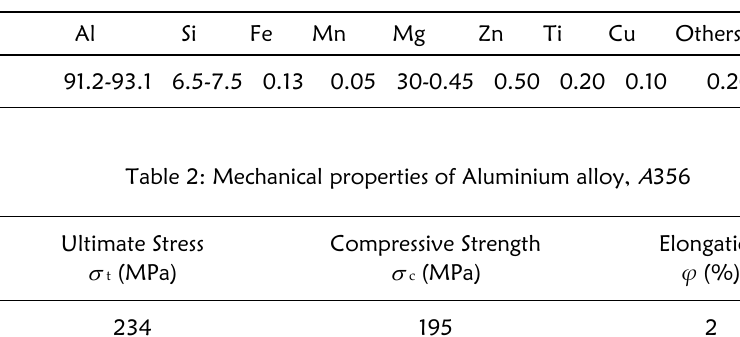
Table 1: Chemical compositions of Aluminium alloy, A356